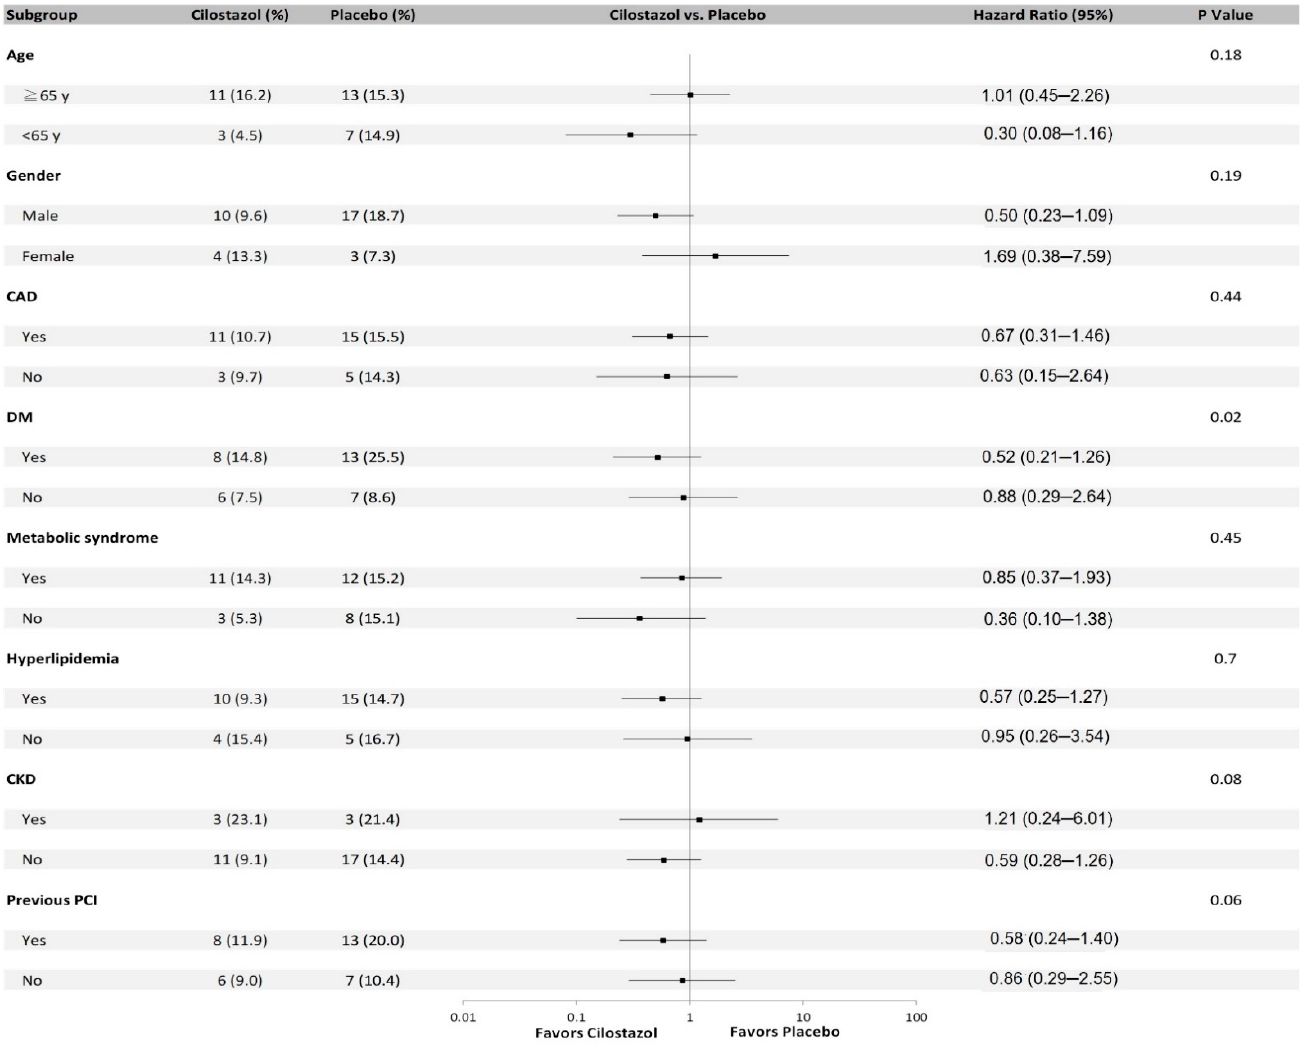
Figure 3. Subgroup analysis of the effect of cilostazol versus placebo on the occurrence of the composite major adverse cardiovascular events.